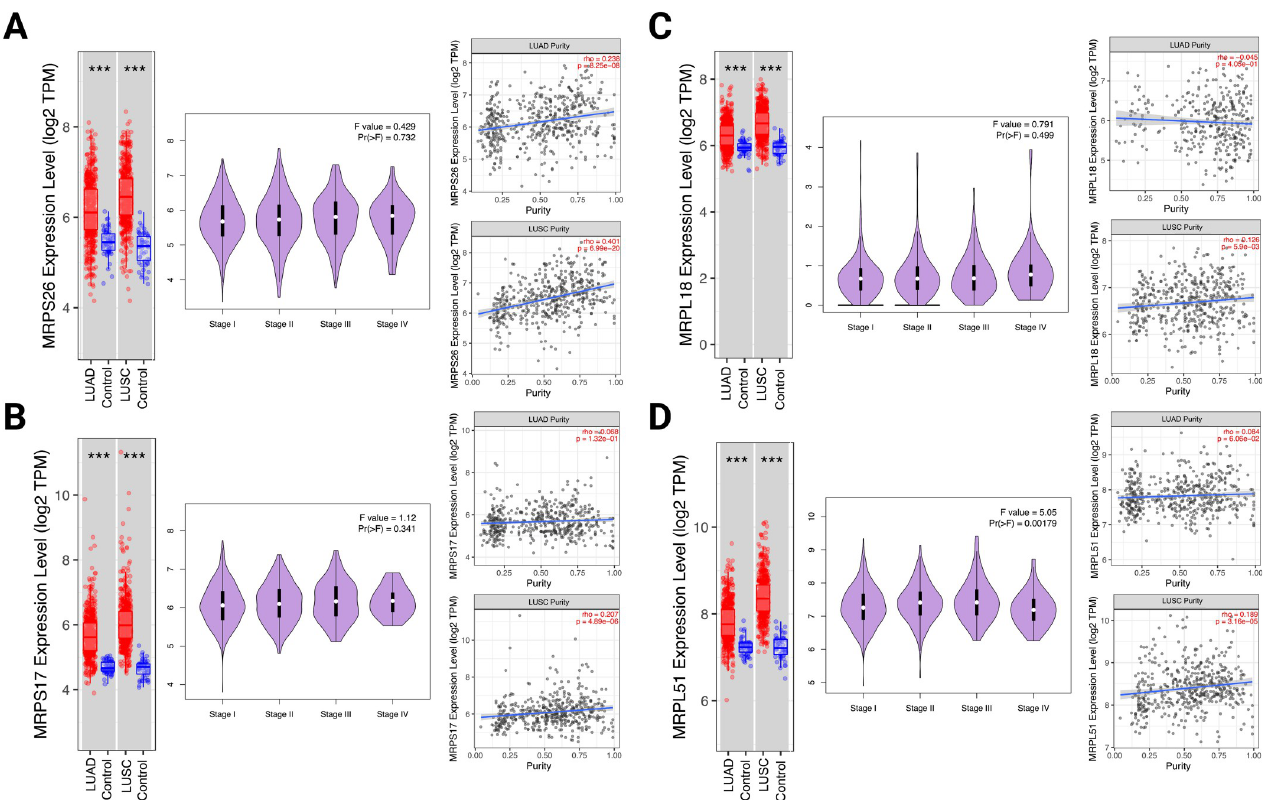
Fig 4. Overall expression, across different stages and in terms of tumour purity of Mitochondrial Ribosomal Protein S26 (MRPS26), Mitochondrial Ribosomal Protein S17 (MRPS17), Mitochondrial Ribosomal Protein L18 (MRPL18) and Mitochondrial Ribosomal Protein L51 (MRPL51) in non-small cell lung cancer tissues from public transcriptome data. Significance was determined using analysis of variance, a Wilcoxon test P < 0.05 and the partial Spearman’s correlation (rho). ��� P < 0.001. LUAD: Lung adenocarcinoma; LUSC: Lung squamous cell carcinoma; TPM: Transcripts per million.